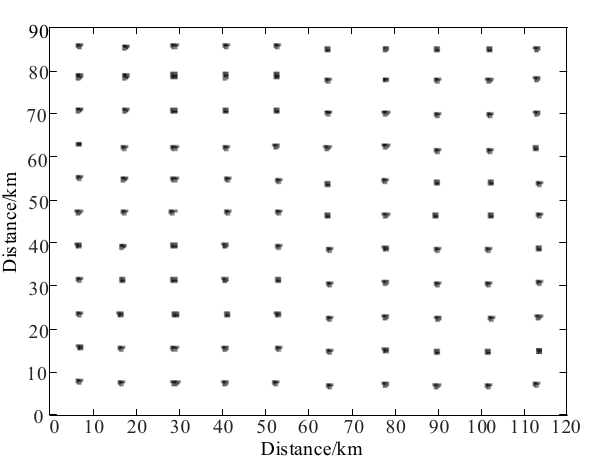
Figure 2. Instantaneous wind field information at the altitude of the aircraft.